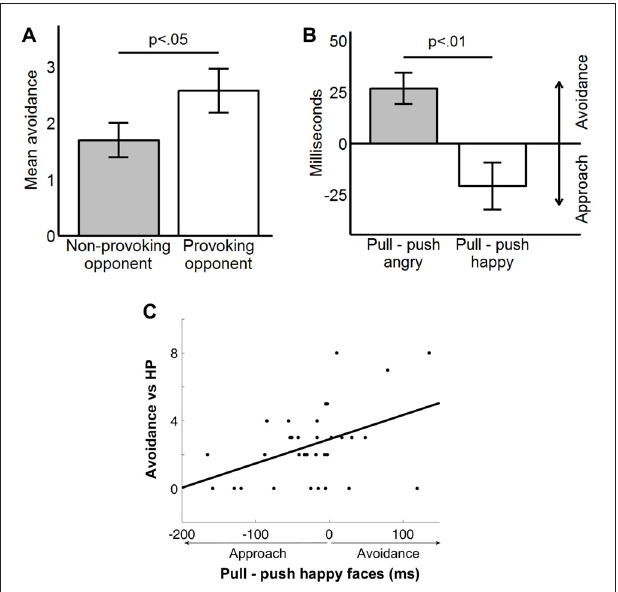
FIGURE 3 | (A) Avoidant behavior against each opponent in the FOE. Values are mean ± standard error. (B) Results of the Approach-Avoidance Task (AAT). (C) Correlation between the approach bias in the AAT (pull minus push for happy faces) and avoidant behavior against the highly provoking (HP) opponent in the